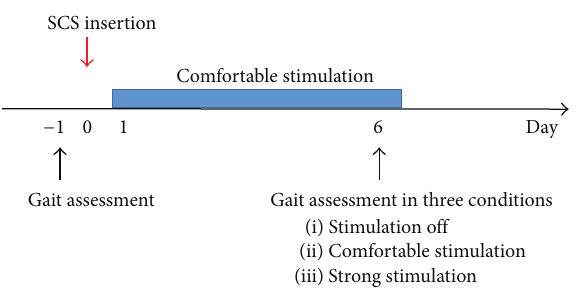
Figure 1: The study design. We evaluated the gait two times: the day before spinal cord stimulation (SCS) insertion and after 6 days of SCSperiod.Atthesecondevaluation,wemeasuredthreeconditions: SCS off, SCS comfortable, and SCS